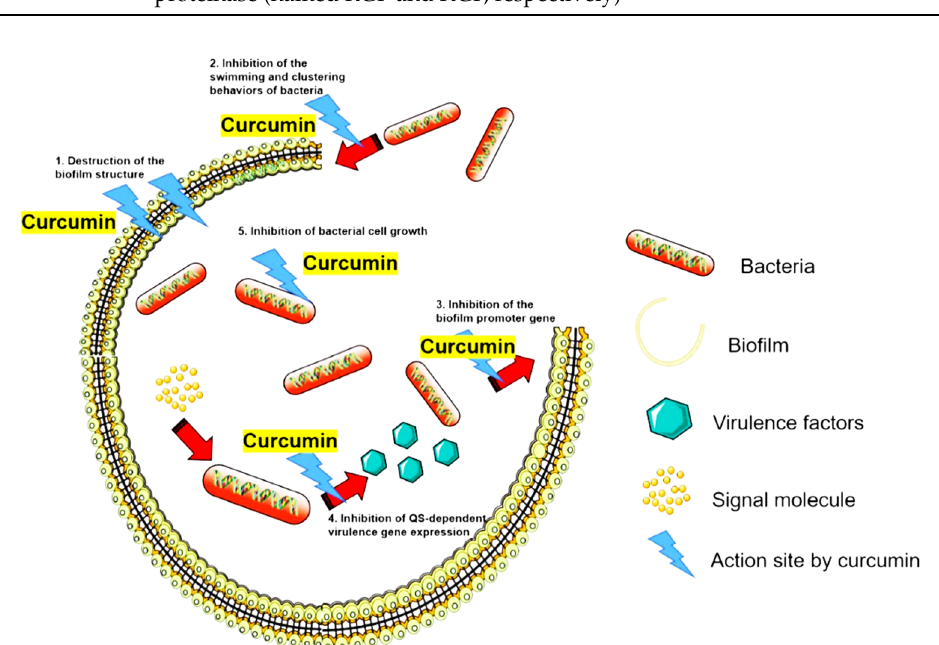
Figure 3. Inhibitory effect of curcumin against the bacterial quorum sensing (QS) system. The main mechanisms of curcumin in QS inhibition involve (1), destruction of the biofilm structure; (2) inhibition of bacterial swimming and clustering behavior; (3) inhibition of the expression of biofilm promotor genes; (4) inhibition of the gene expression of QS-dependent virulence; (5) inhibition of bacterial cell growth [35,36,38,50,53–55]. Table 2. Targets or action model of curcumin in the inhibition of biofilm in various bacteria.